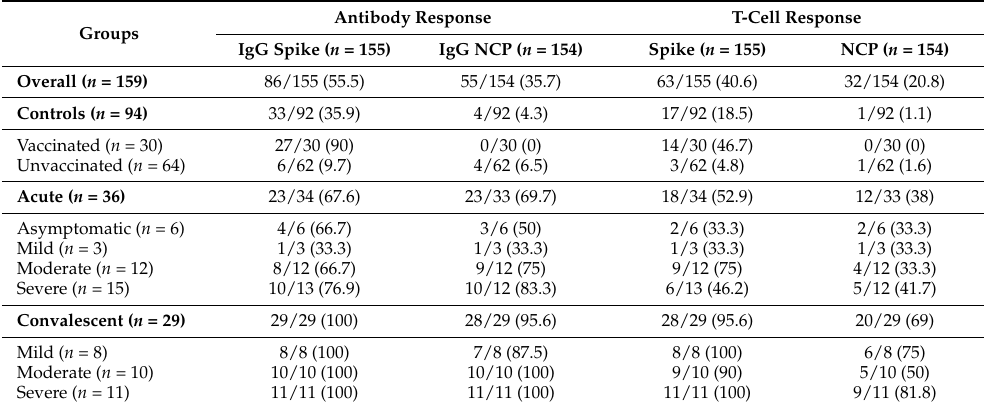
Table 3. Overall positivity results obtained using antibody detection and T-cell IFN- γ production detection after spike and NCP stimulation including borderline results (%).